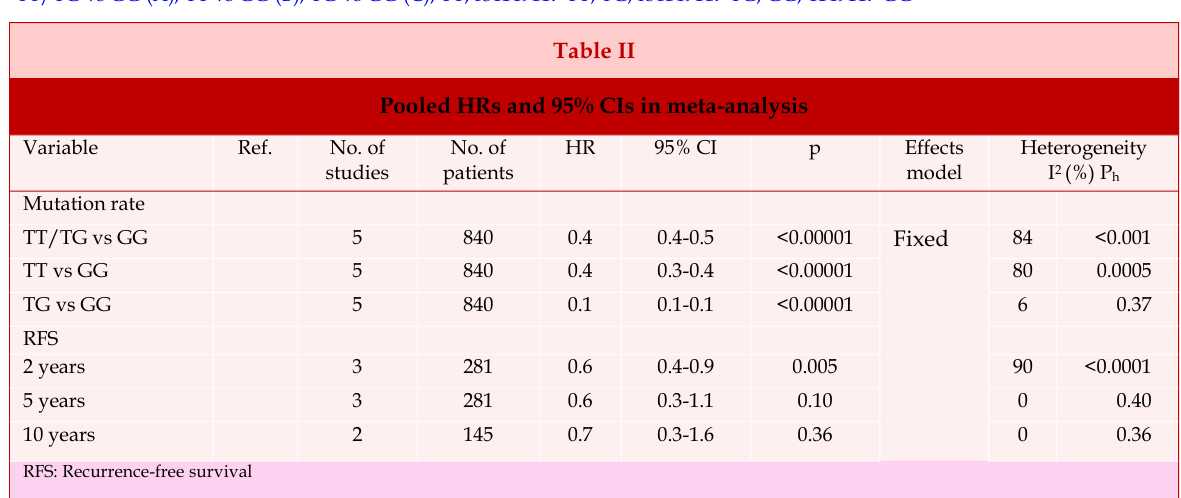
Figure 2: Association between the mutation rate of SLCO1B3 (rs4149117) and prostate cancer risk TT/TG vs GG (A), TT vs GG (B), TG vs GG (C); TT, rs4149117 TT; TG, rs4149117 TG; GG, 4149117